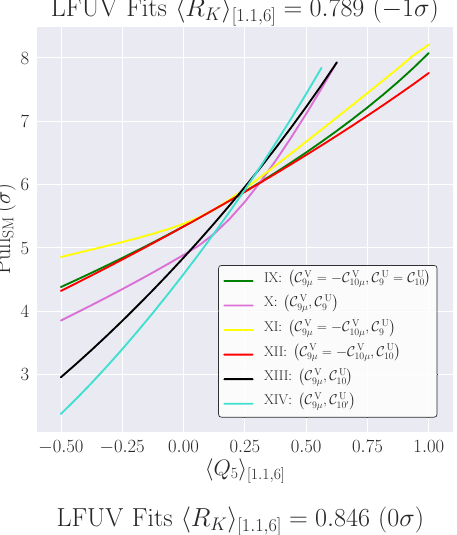
for different values of Q 5 (cid:31) (cid:30) [1 . 1 , 6]